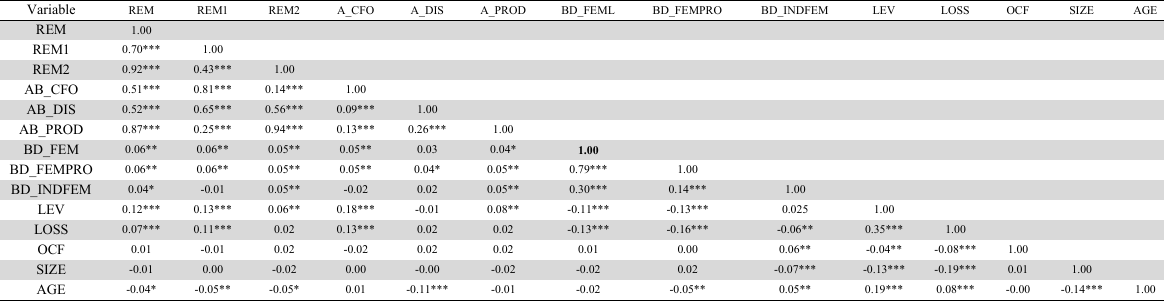
The summary of Pearson correlation